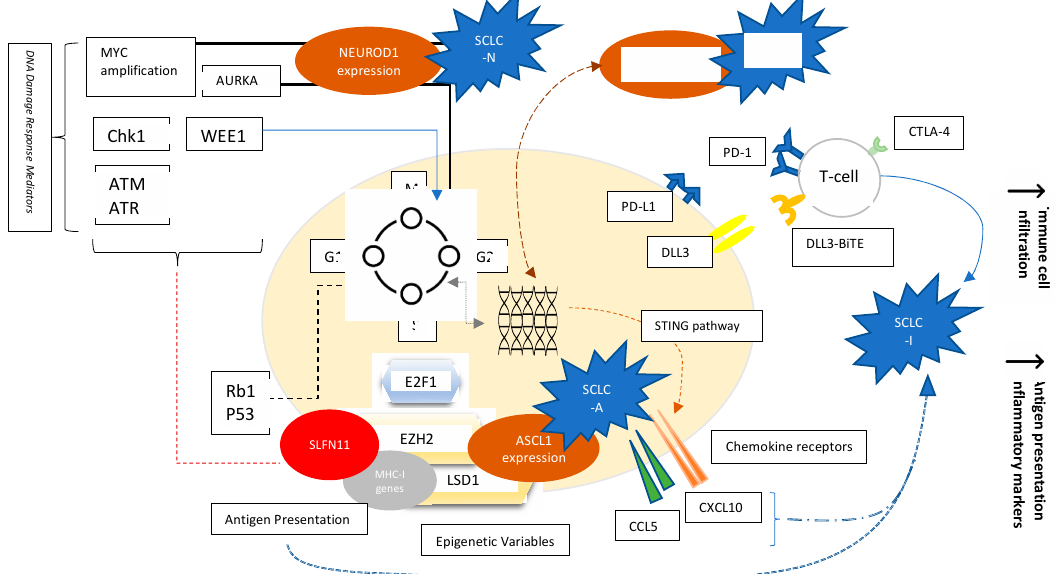
Figure 1. Factors affecting SCLC biology. Molecular Variables, Signaling Pathways, Transcription factors, Epigenetics, and Cell-surface Receptors. Evolving concepts in the understanding of SCLC include the following: The ubiquitous loss of TP53 and Rb1 involved mainly in the G1-S phase cellular cycle checkpoints; NEUROD1, ASCL1, and POUF2 expression as determinants of SCLC subtypes; Over-expression of AURKA involved in the G2-M checkpoint, and characterizing the MYC-driven NEUROD1 high SCLC-N subtype; Role of DNA damage response mediators such as Chk1, WEE1, ATM/ATR, as well as AURK; Role of epigenetics such as EZH2 and LSD1; Role of EZH2 influencing response to chemotherapy by alteration of SLFN11 and immune phenotype by effect on MHC-I presentation; Role of EZH2 in affecting ASCL1 expression responsible for SCLC-A phenotype through TGF-beta-SMAD pathway; Variable expression of chemokine receptors dependent on STING pathway; PD-L1 and DLL3 studied as targetable cell-surface